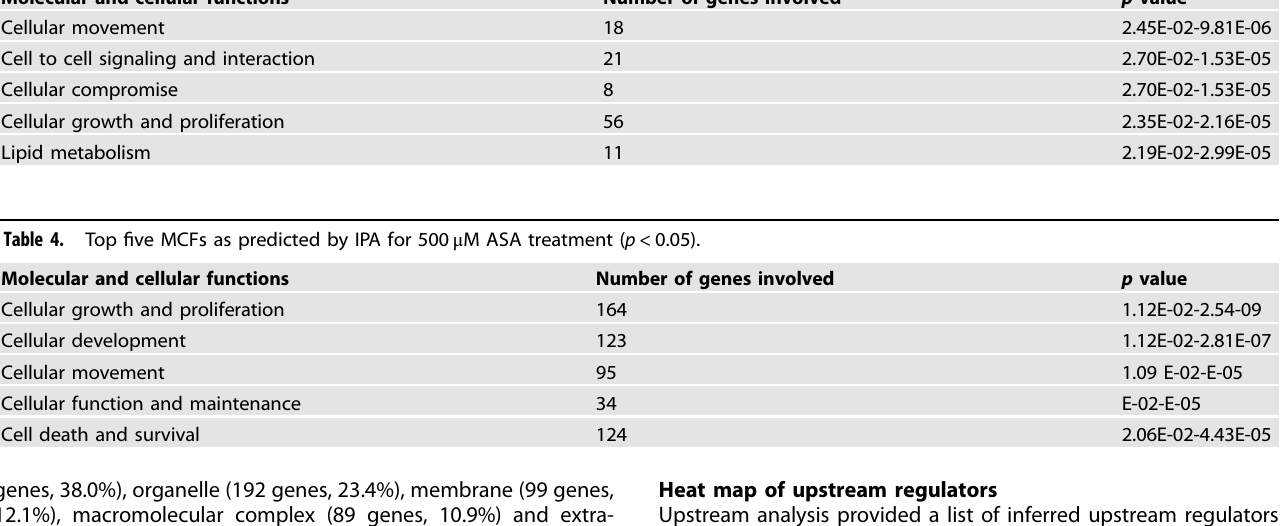
Table 3. Top fi ve MCFs predicted by IPA for 200 μ M of ASA treatment (p < 0.05). Molecular and cellular functions